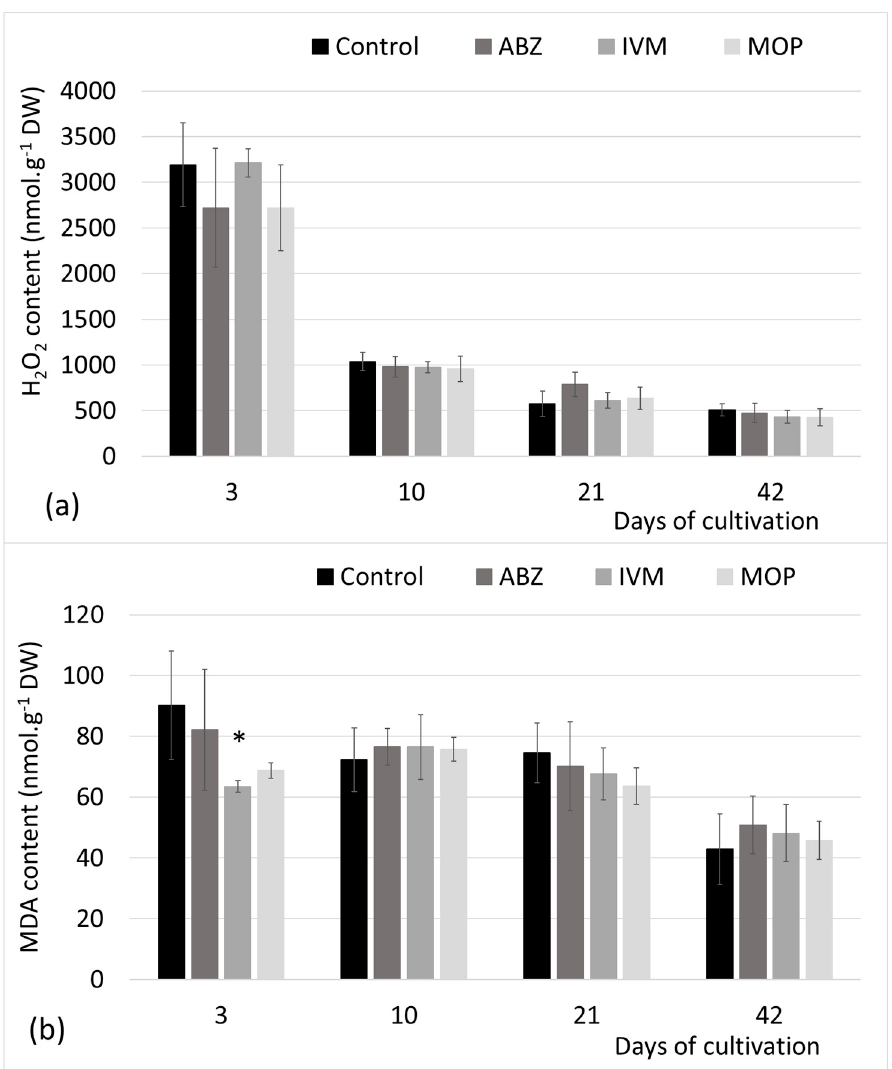
Figure 1. Changes in hydrogen peroxide ( a ) and malondialdehyde content ( b ) in T. pratense shoots cultivated with the manure of sheep treated with albendazole (ABZ), ivermectin (IVM) or monepantel (MOP) in time. The data are expressed as mean ± SD, n = 3. Asterisks mark statistically significant differences comparing to control up to alpha ≤